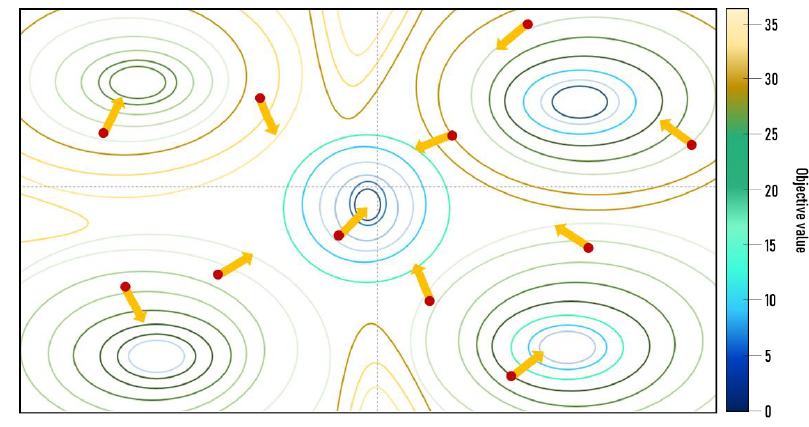
Figure 13. Particle swarm optimization (PSO) algorithm.